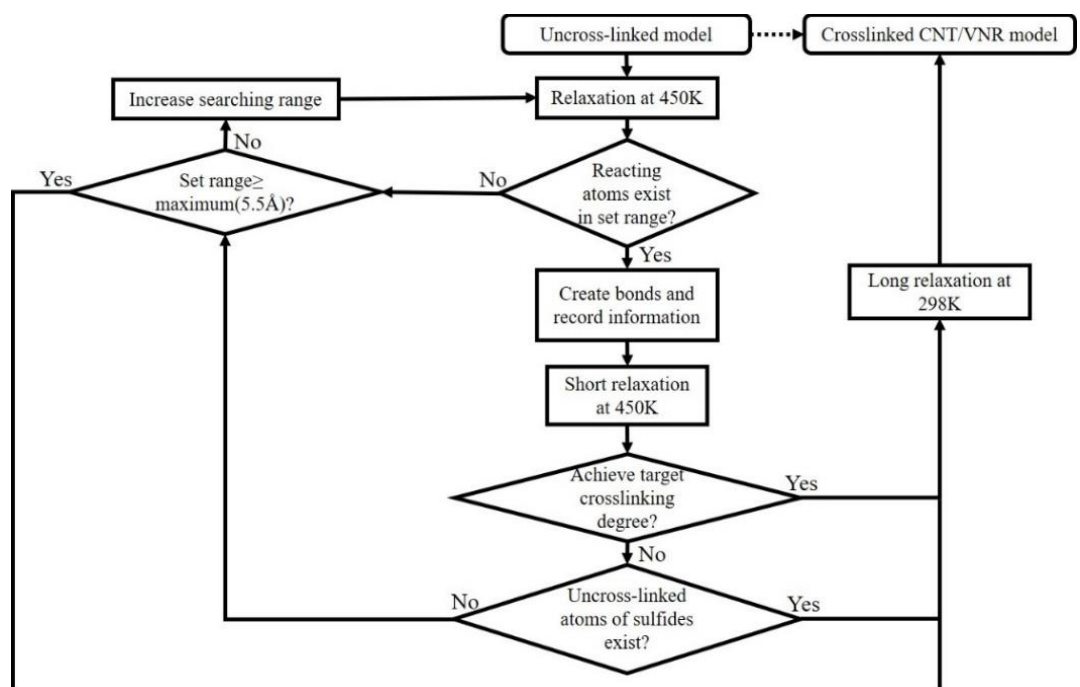
Figure 3. Flow chart of the programing of vulcanization process.